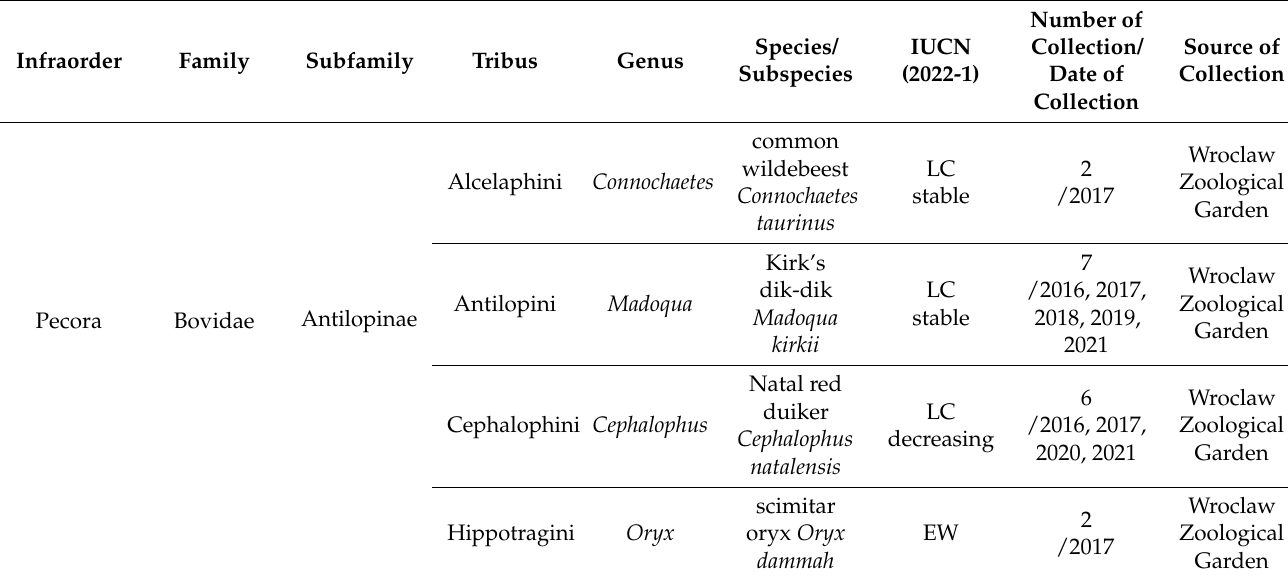
Table 1. Characteristics of the examined